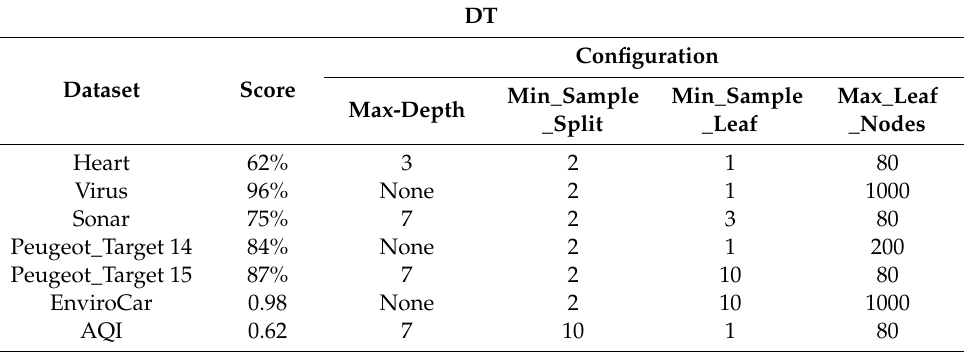
Table 25. DT performance and configuration for PCA = 30%.